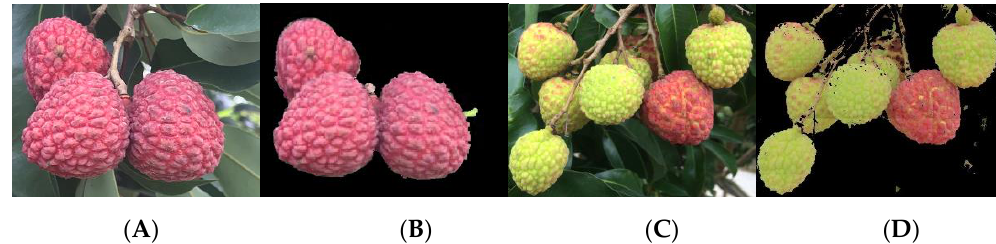
Figure 6. Performance evaluation of lychee foreground segmentation. ( A ) Original image of a lychee cluster, which is labelled I 1 . ( B ) Foreground segmentation result of I 1 . ( C ) Original image of a lychee cluster, which is labelled I 2 . ( D ) Foreground segmentation result of I 2 .